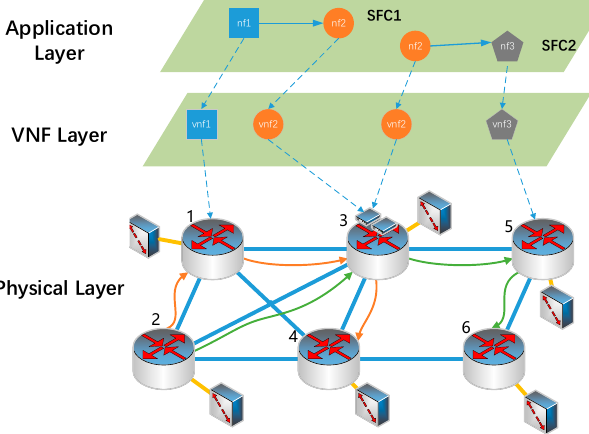
Figure 1. SFC mapping architecture.